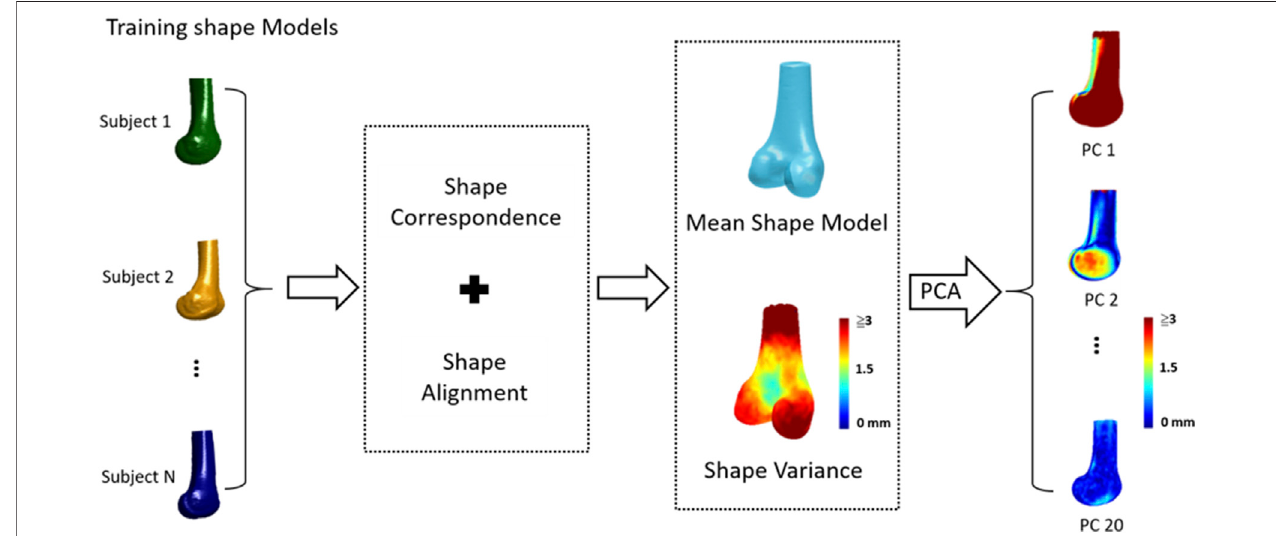
FIGURE 1 | The general procedure of statistical shape modeling (SSM) for the human knee: 1) a set of CT-derived training shape models, 2) choosing a reference model;3)establishingshape(mesh)correspondenceandalignmentbetweenindividualtrainingmodels;4)determiningthemeanshapemodelandshapevariations;and 5) determining primary modes of shape variations using Principal Component Analysis